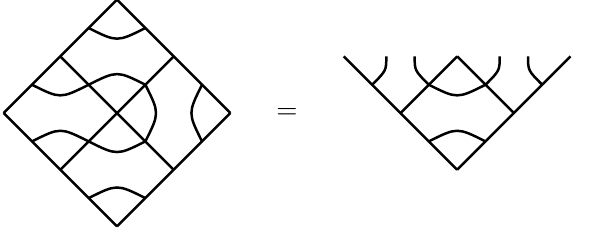
Figure 4 . Graphical interpretation of the Temperley Lieb algebra e i e i (cid:0) 1 e i = e i . Stacking the tiles in the left-hand part of the (cid:12)gure corresponds to the following string of Temperley Lieb operators: e i I i +1 e i (cid:0) 1 e i = e i e i (cid:0) 1 e